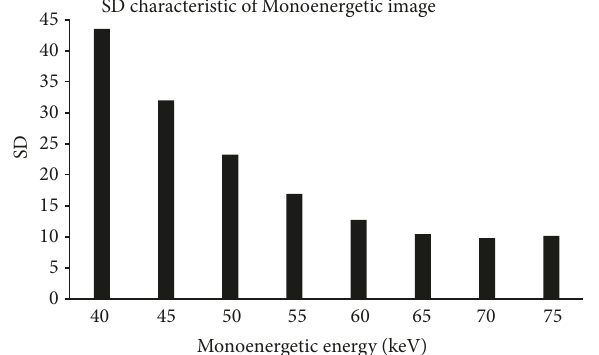
Figure 9: The SD characteristic of a monoenergetic image. Image SD increased by 25% for each reduction of 5 kV between 40 and 65 kV; it did not increase and maintained a consistent level for energies higher than 65 kV.